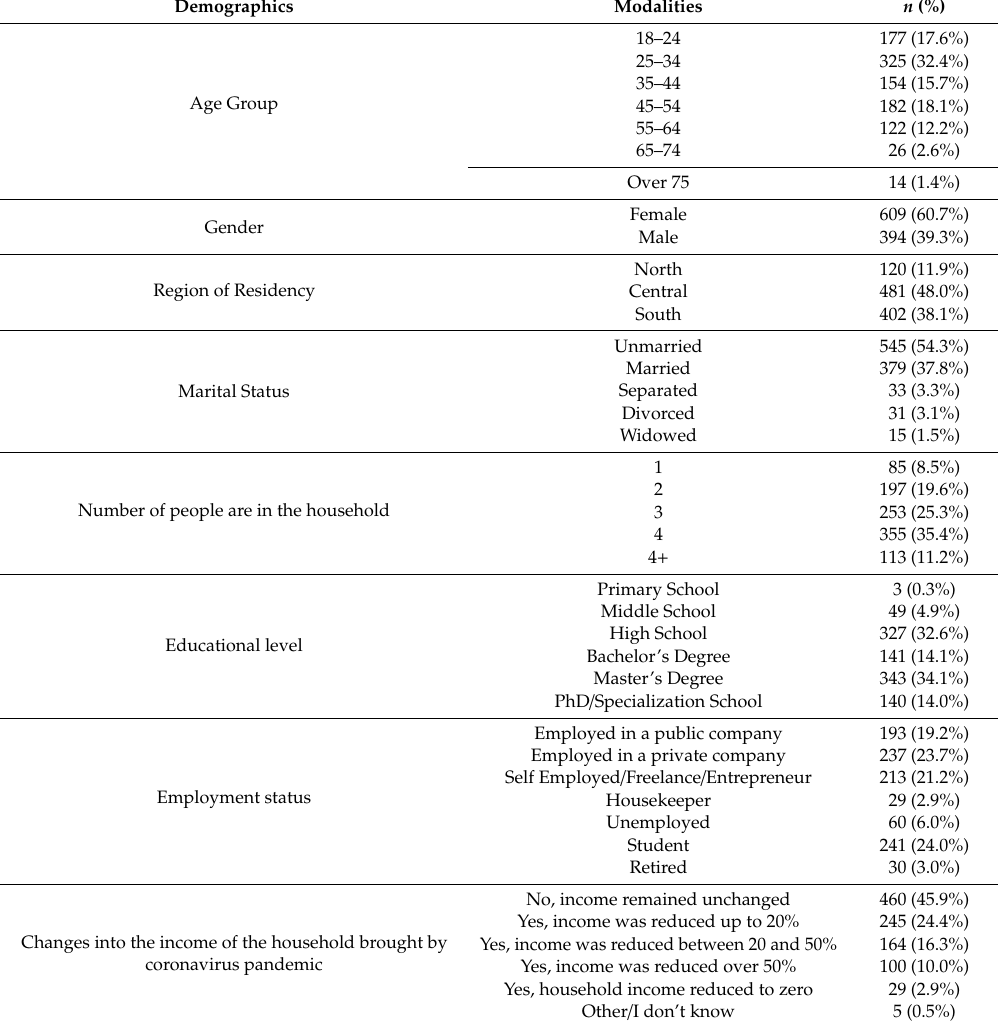
Table 1. Demographic information of the respondents to the questionnaire ( n =